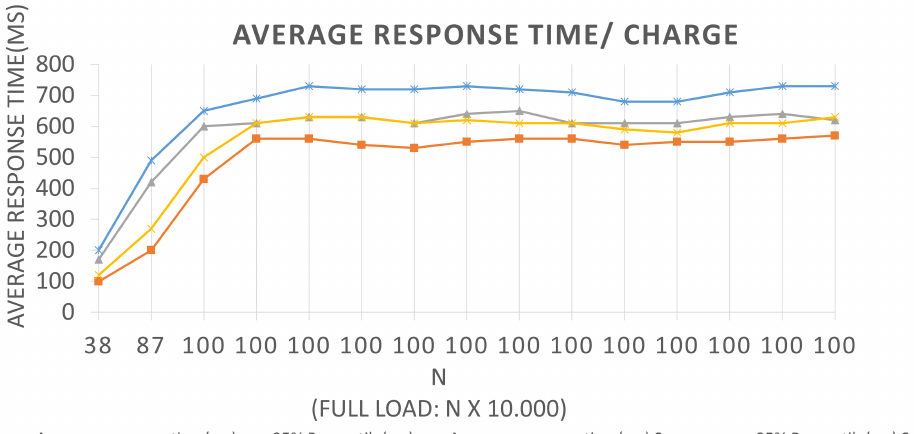
Figure 13. Results of the experiments for query